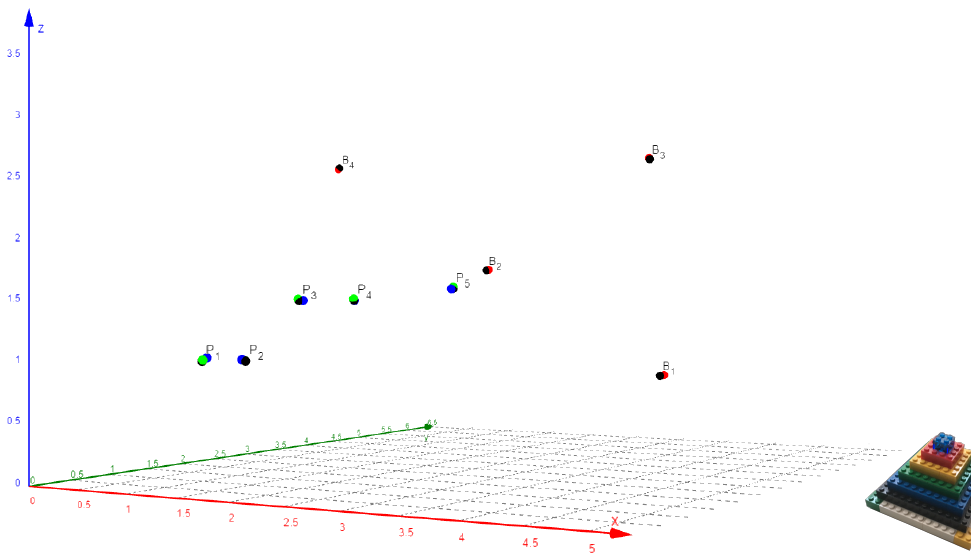
Figure 14. Experimental measures and calibration pyramid